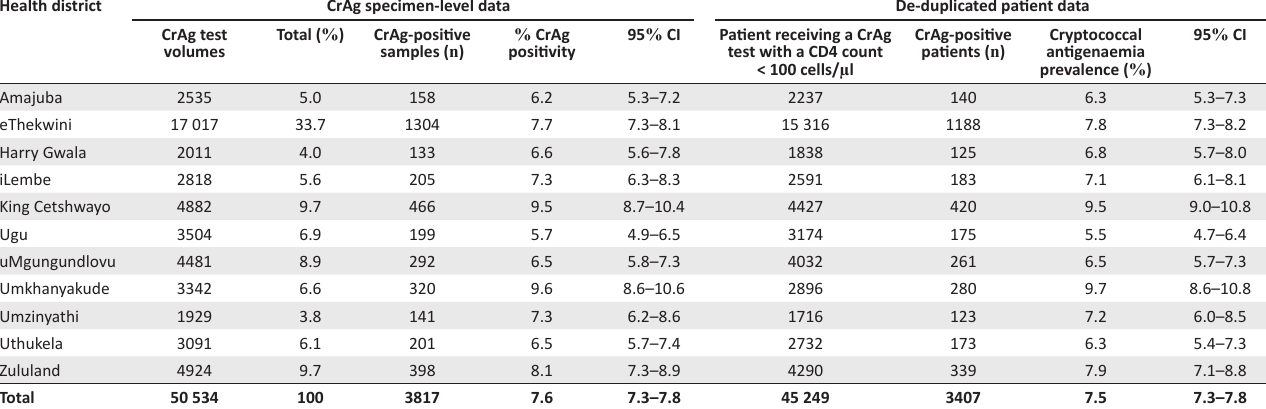
TABLE 2: Analysis of district CrAg positivity in KwaZulu-Natal between October 2016 and June 2017 for screened samples and de-duplicated patients de-duplicated patient data. Health